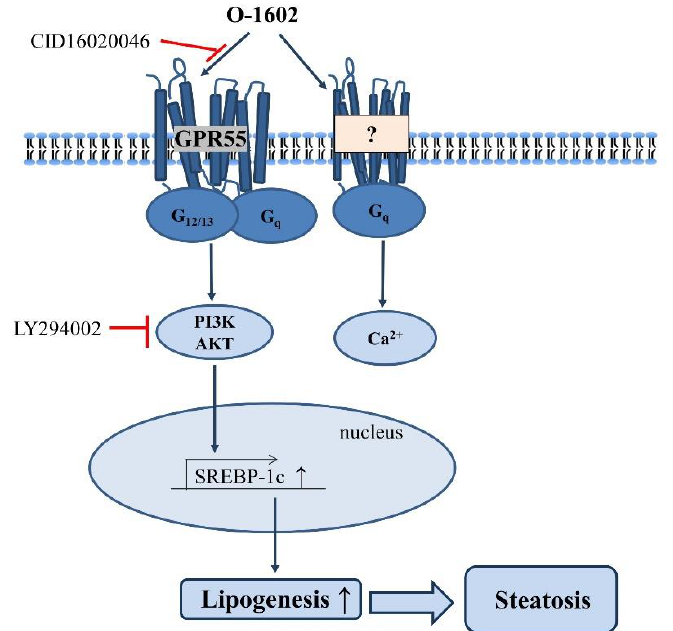
Figure 8. Proposed signaling pathway and mechanism of O-1602 on lipid accumulation in hepatocytes . O-1602 activation of GPR55 induces steatosis by inducing SREBP-1c through activation of PI3K/AKT and O-1602 induces Ca2+ increase in a GPR55-independent manner in hepatocytes.